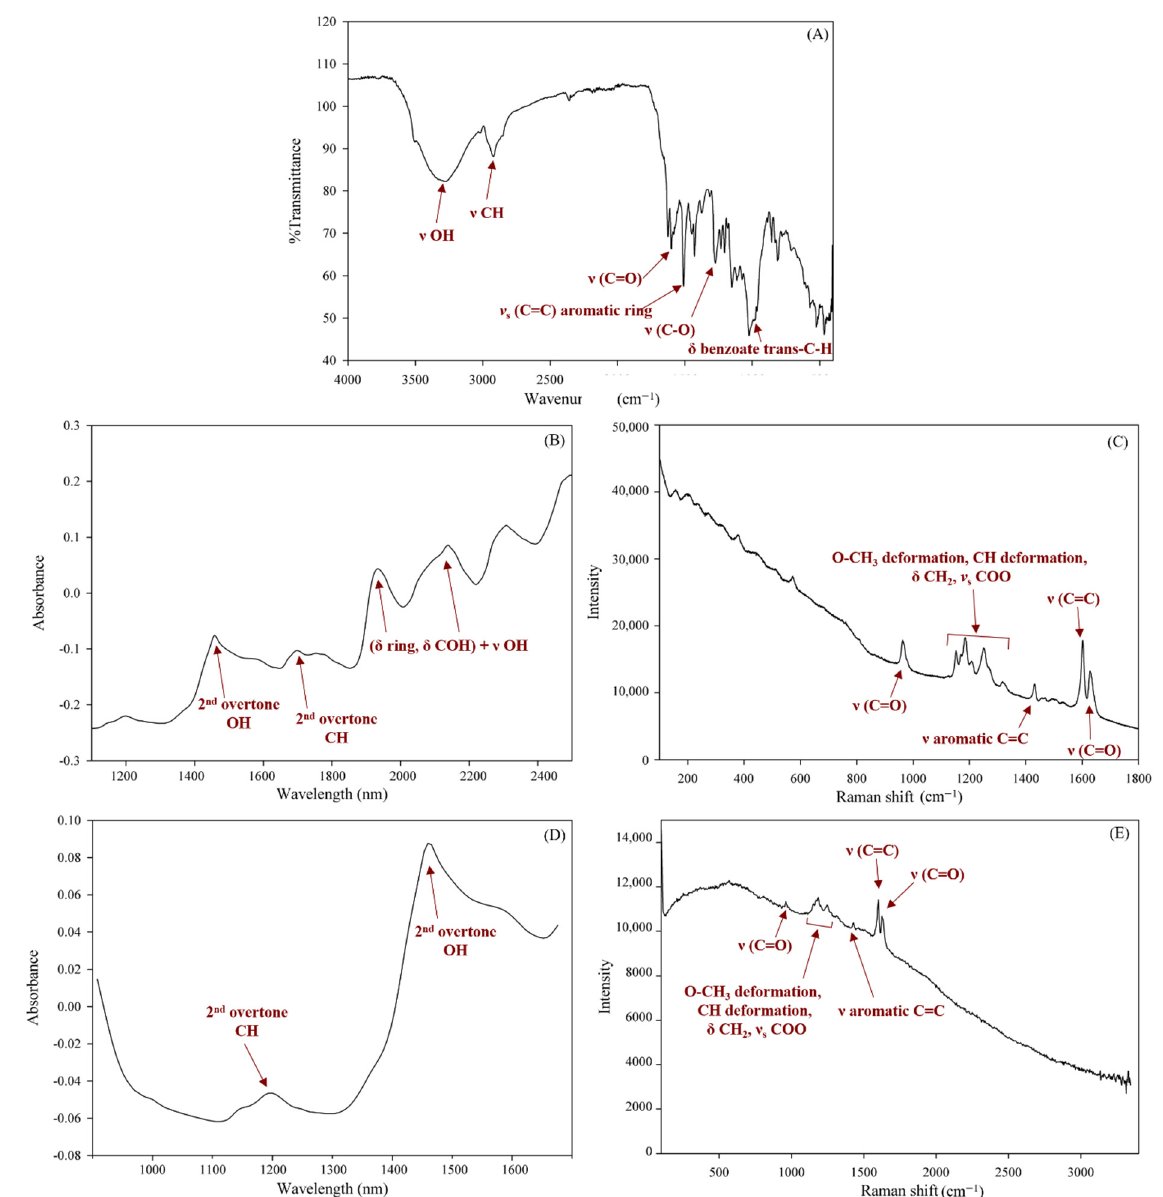
Figure 2. Spectra obtained from ( A ) benchtop FT-IR, ( B ) benchtop NIR, ( C ) benchtop Raman, ( D ) portable NIR, and ( E ) portable Raman spectrometer.